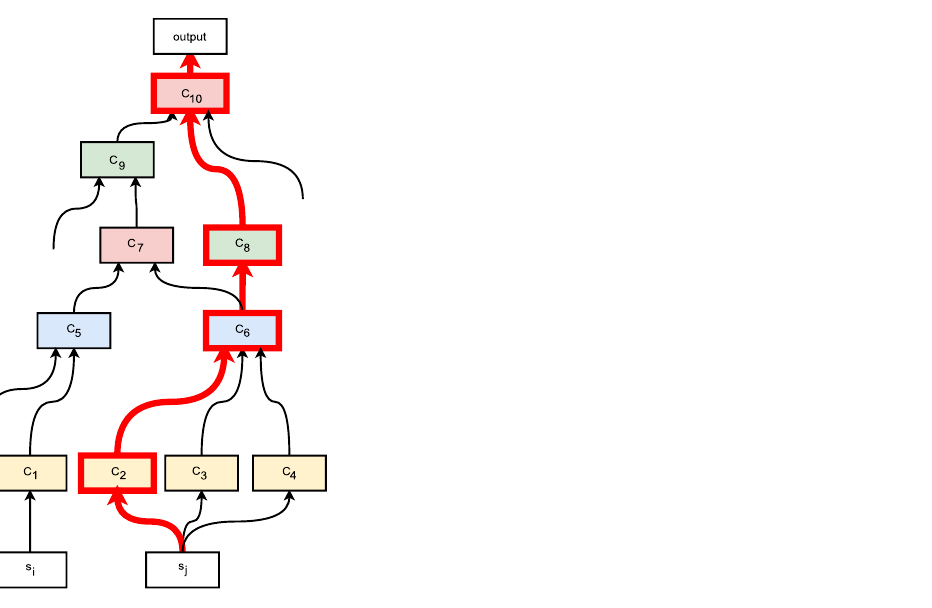
Figure 14. Highlighted in red is one of the paths that have as source node the data source denoted by s j and that is processed by the architectural components C 2 , C 6 , C 8 , and C 10 before joining the architecture’s output